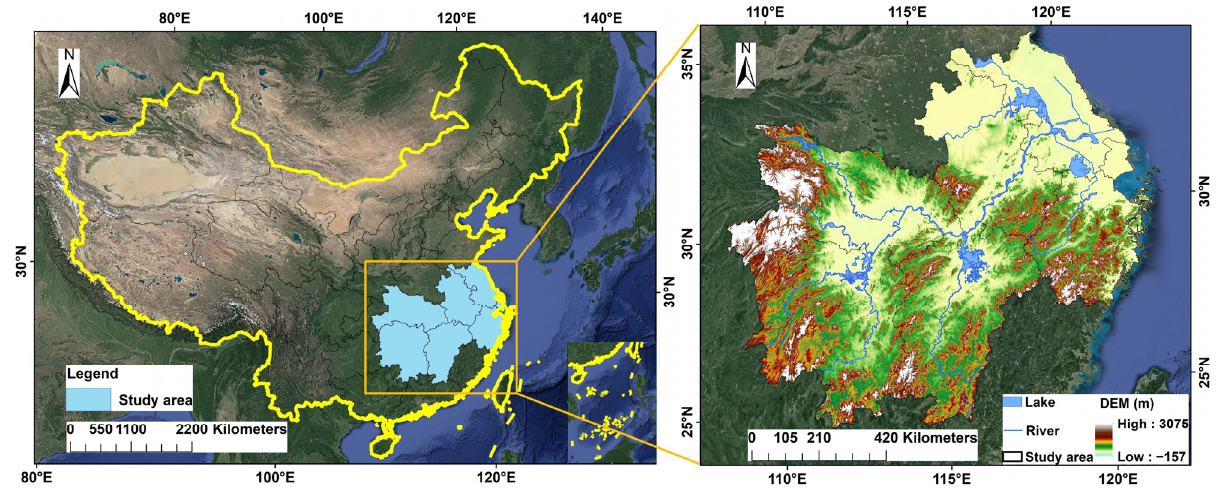
Figure 1. The location of the study area.